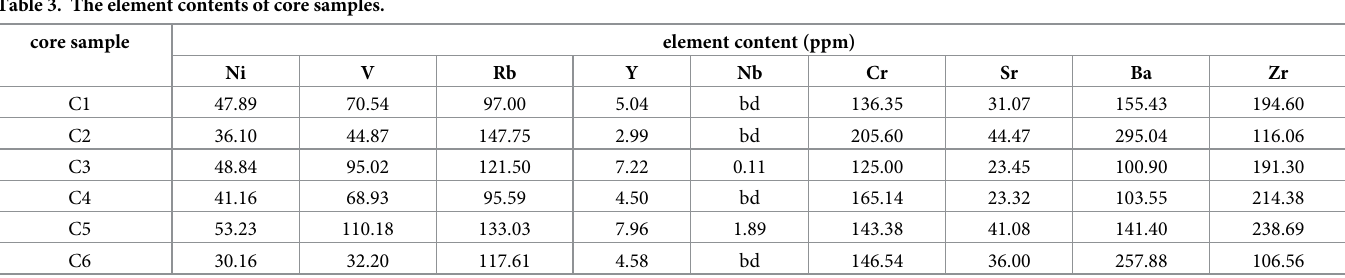
Table 3. The element contents of core samples.